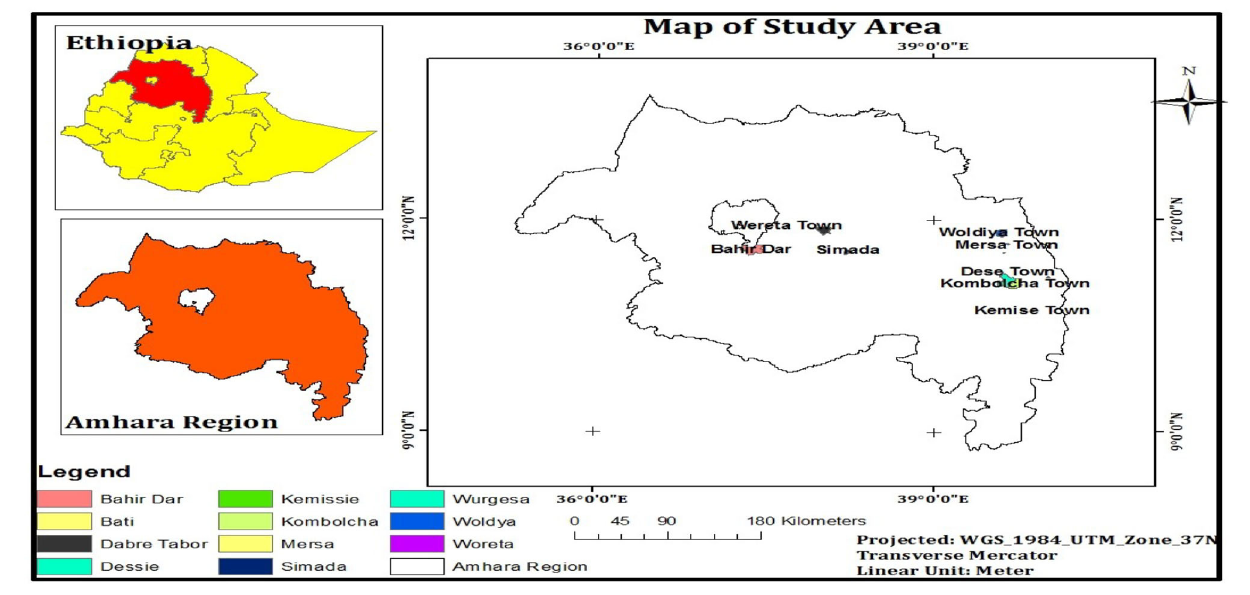
FIGURE 2 | Map of the study